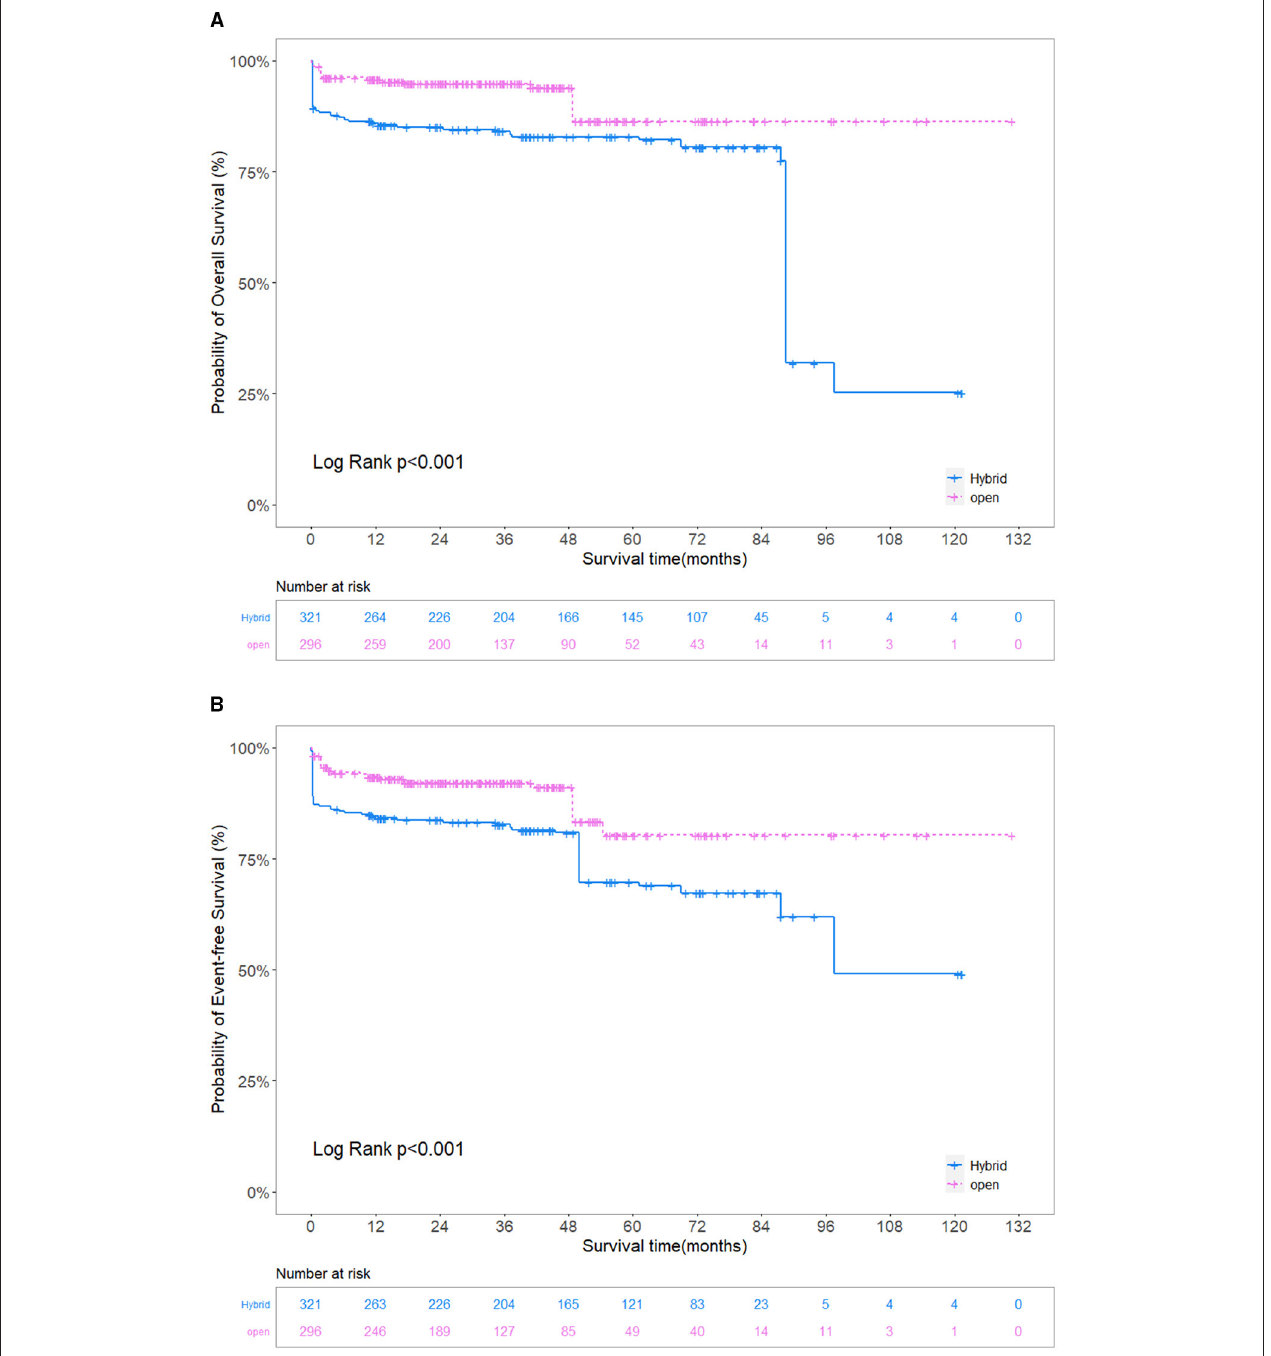
FIGURE 5 | (A) Adjusted comparison of the overall survival. (B) Adjusted comparison of the event-free survival. The overall survival and event-free survival in the SET group were significantly better than those in the HAR group. SET, stent elephant trunk procedure combined with supra-aortic branch reconstruction; HAR, hybrid procedure combined TEVAR with extra-anatomic